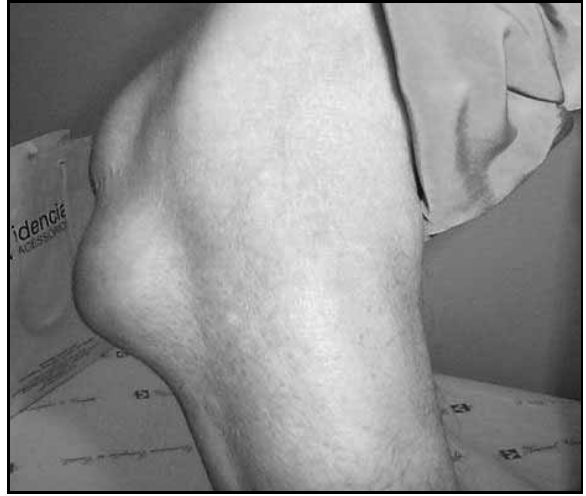
Figura 2 – Nódulos reumatoides em